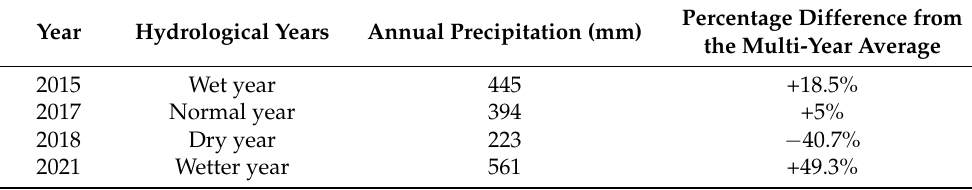
Table 2. Division of hydrological